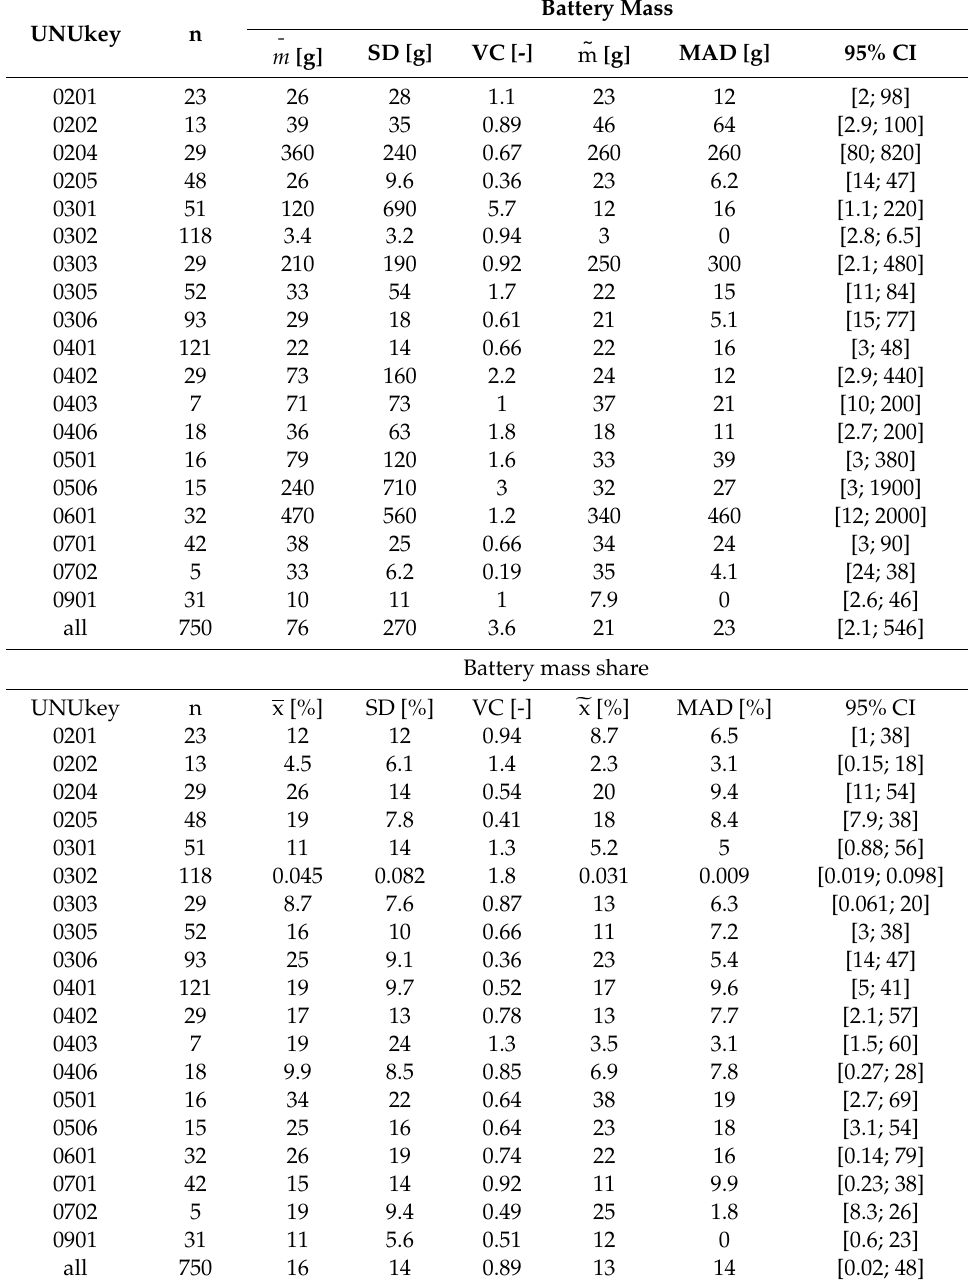
Table A2. Statistics on battery mass and mass share, di ff erentiated by